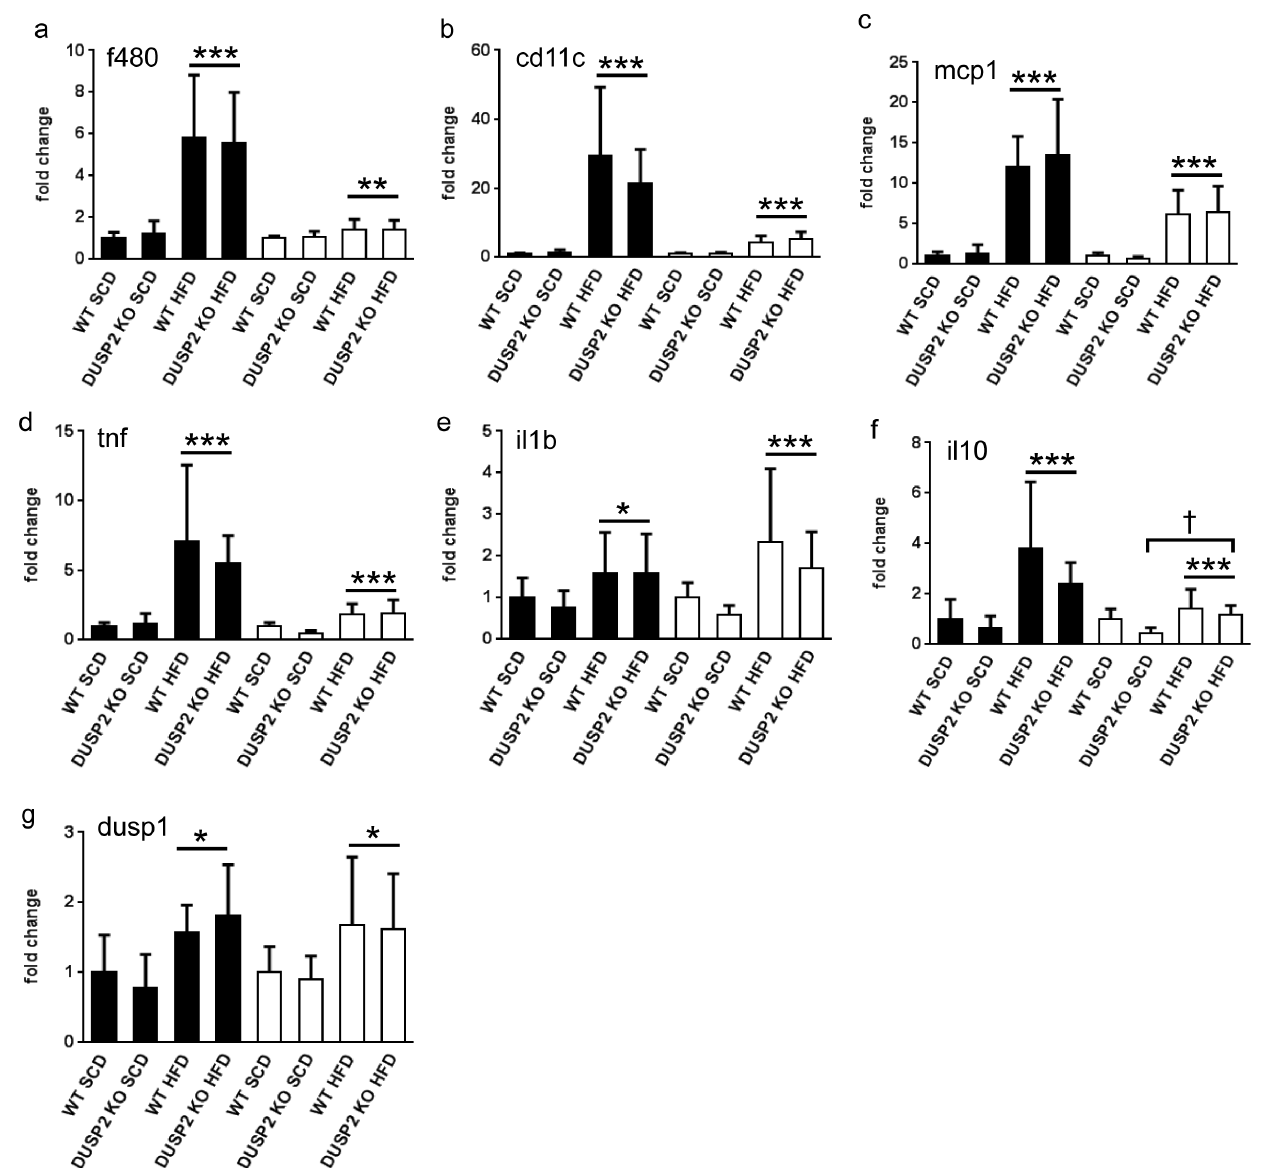
Figure 5. Inflammation in the WAT of wt and dusp2 2 / 2 male and female mice. The mRNA expression of ( a ) f480 ; ( b ) cd11c ; ( c ) mcp1 ; ( d ) tnf ; ( e ) il1b ; ( f ) il10 and ( g ) dusp1 in epididymal adipose tissue. *p , 0.05 Main Effect SCD vs. HFD; **p , 0.01 Main Effect SCD vs. HFD; ***p , 0.005 Main Effect SCD vs. HFD; { p , 0.05 Main Effect wt vs. dusp2 2 / 2 . Data are mean 6 SD. Black bars are male mice, white bars are female mice. Ns are 5, 8, 8 and 8 for male mice and Ns are 8, 8, 6 and 7 for female mice for wt SCD, dusp2 2 / 2 SCD, wt HFD and dusp2 2 / 2 HFD,